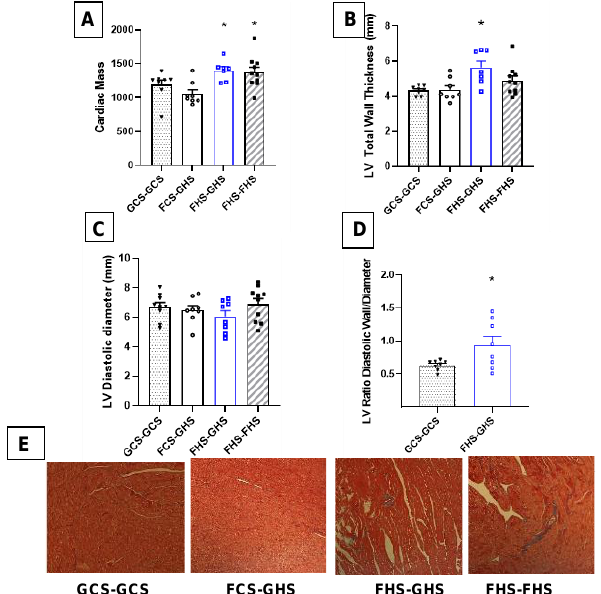
Figure 4. Assessment of Left Ventricular Parameters in Phase III. Images were acquired using a short axis view of the left ventricle (LV) via M-Mode. ( A ) Cardiac mass was the total wet weight of the heart after harvesting. ( B ) Total wall thickness was the sum of anterior and posterior LV wall widths. ( C ) LV diastolic diameter was the diameter of the LV at end diastole. ( D ) LV diastolic wall/diameter was calculated as the ratio of total wall thickness to the diameter of the LV at end-diastole. Values are the mean ± SE, n as indicated per group; * p < 0.05 vs. GCS-GCS. ( E ) Representative histological sections of LV tissue from each group. Group labels are as described in the legend for Table 1. Mason’s trichrome; 40 × magnification.